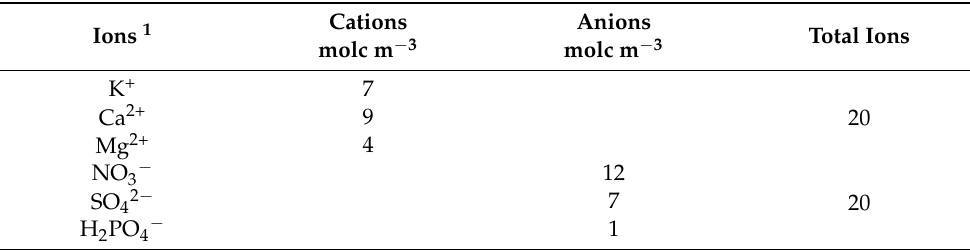
Table 1. Steiner nutrient solution. Ions 1